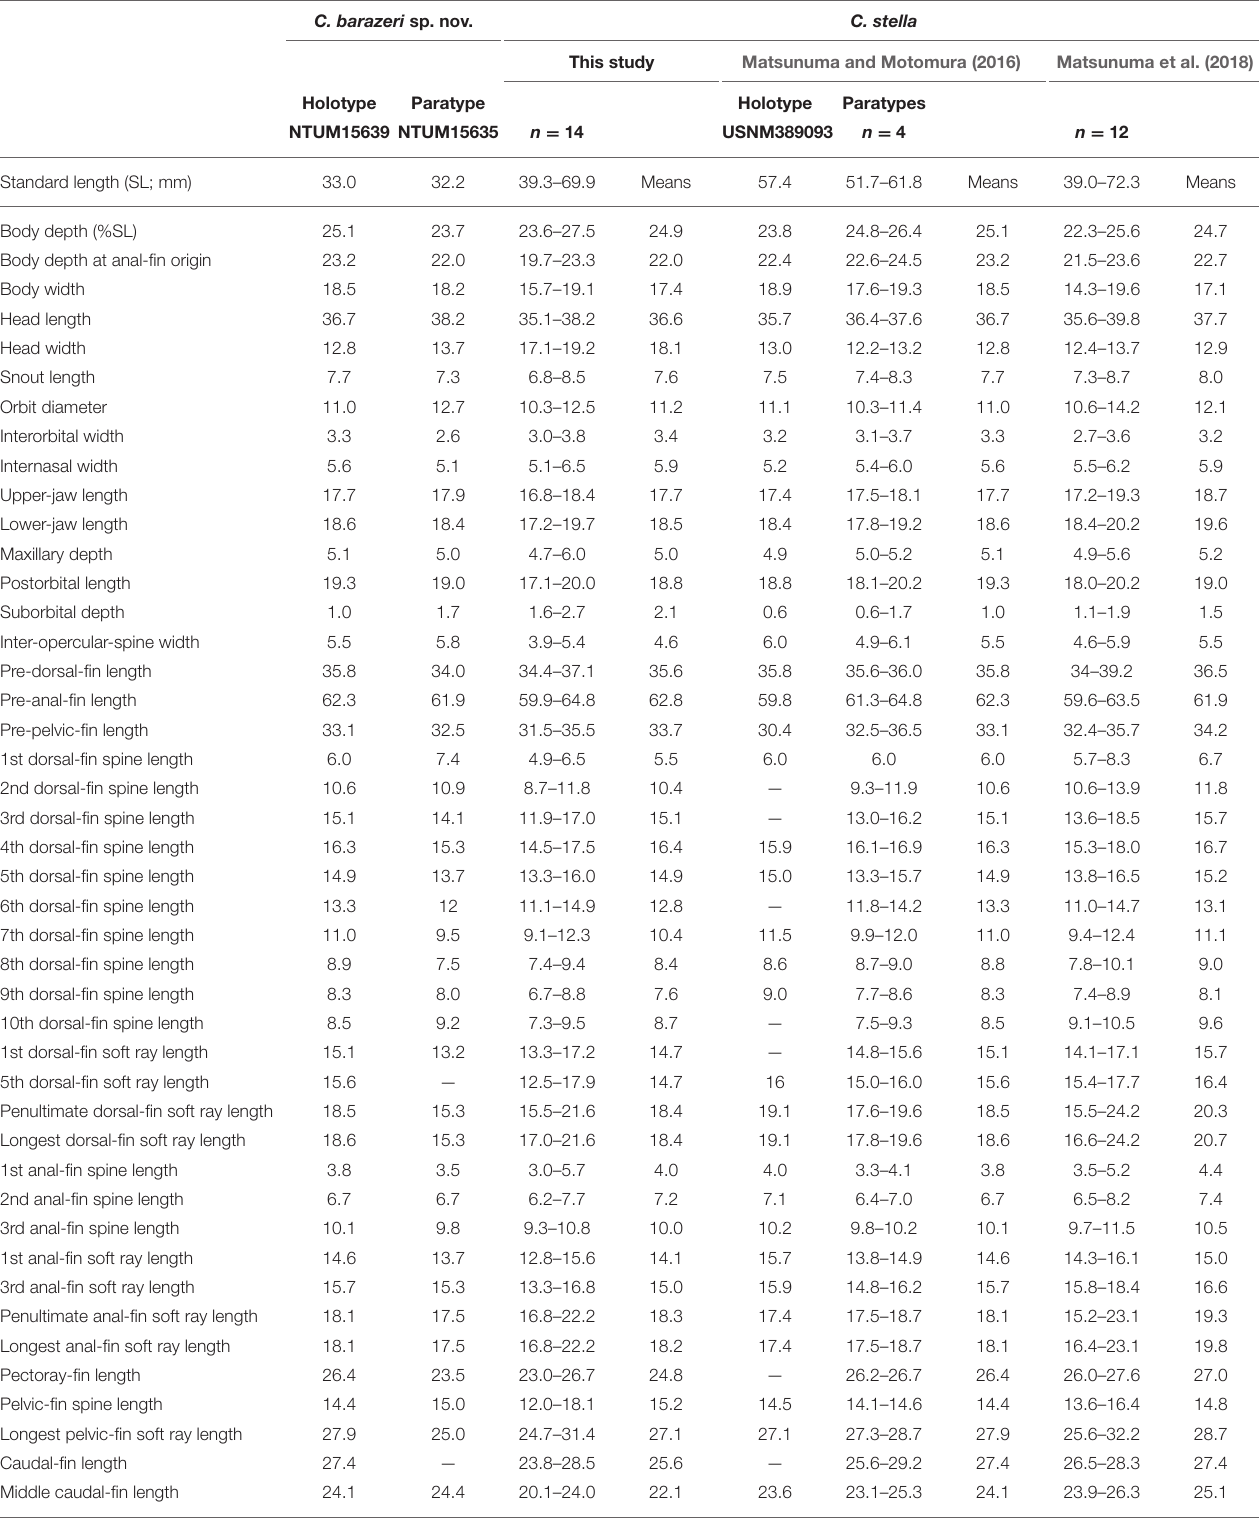
TABLE 7 | Mophometrics expressed as percentages of the standard length from Chelidoperca barazeri sp. nov and C. stella (including examined specimens and reference